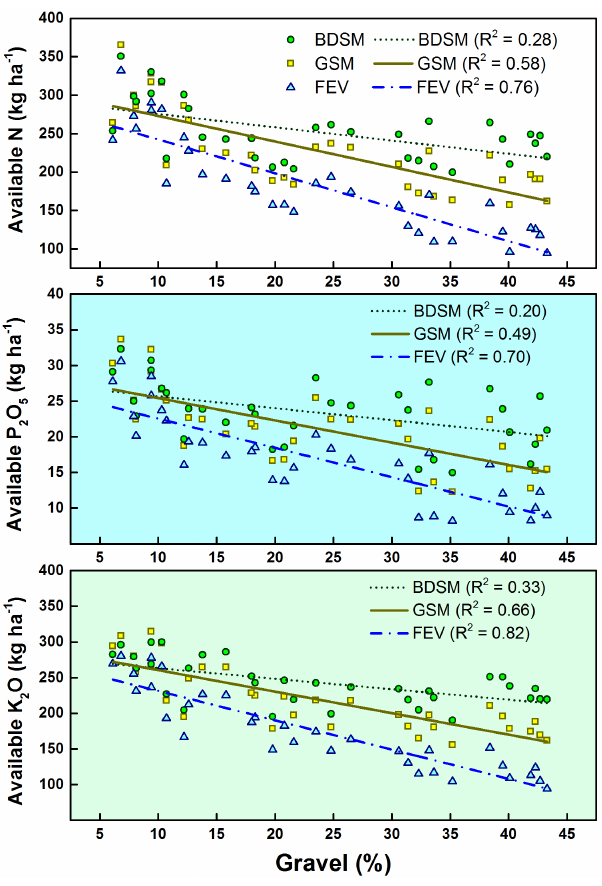
Figure 4. Soil-available N, P 2 O 5 and K 2 O in relation to gravel con- tent with GSM (generalized soil mass), BDSM (bulk-density-based soil mass) and FEV (fine-earth-volume-based)